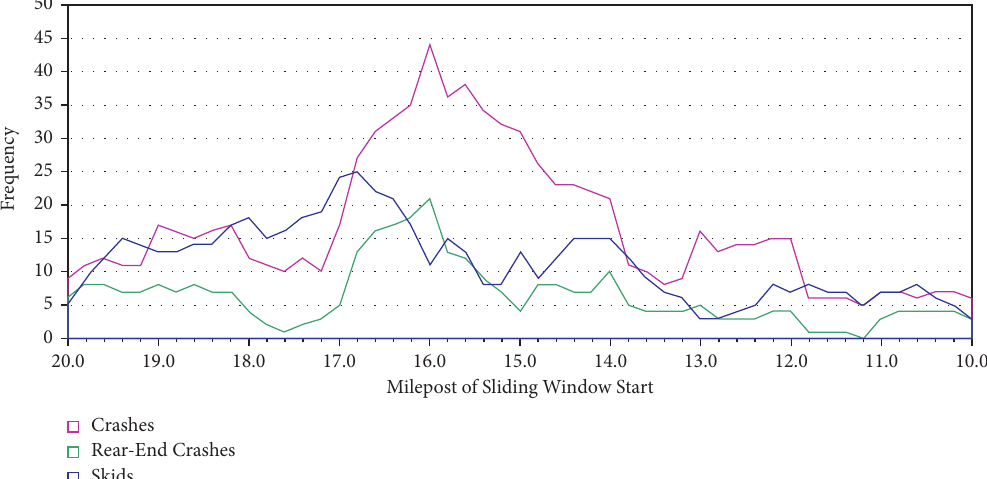
Figure 16: Sliding windows crash/skid frequency on interstate 80 westbound (1.0-mile windows, 0.20-mile